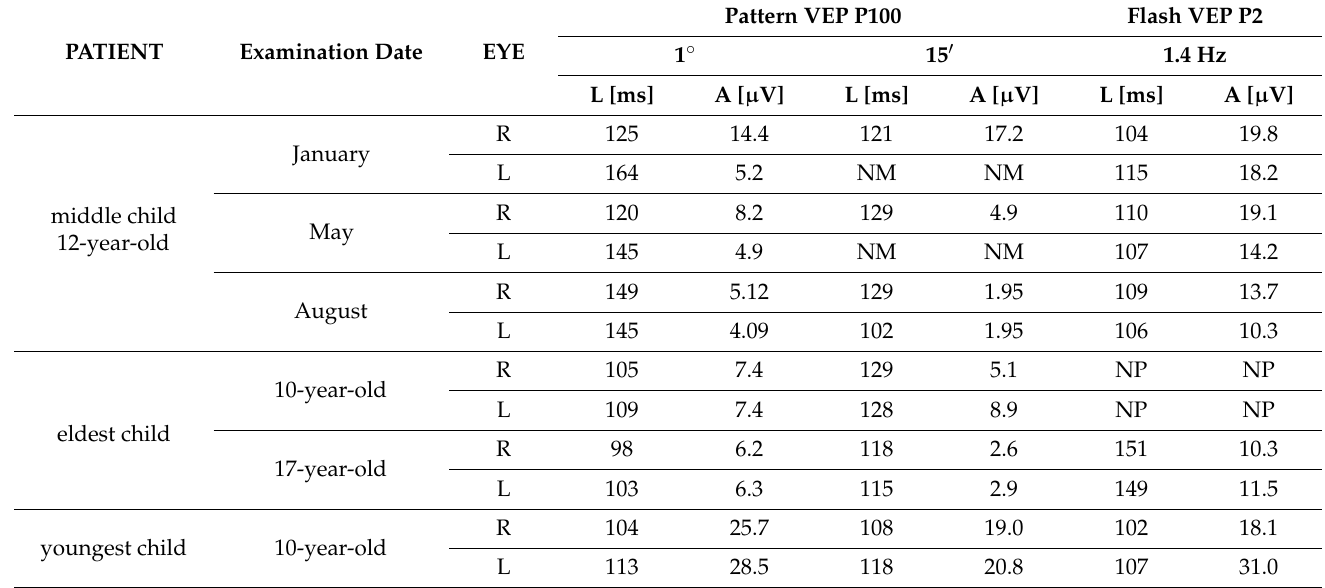
Table 1. Pattern and Flash Visual Evoked Potentials (VEP). The latency (L) and amplitude (A) of P100 waves and P2 waves. R—right eye; L—left eye; NM—non-measurable; NP—not performed.